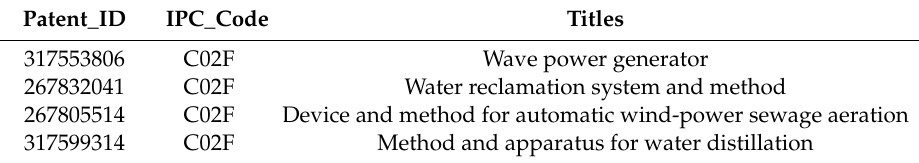
Table 2. Examples of patent titles from the European Patent O ffi ce (EPO)